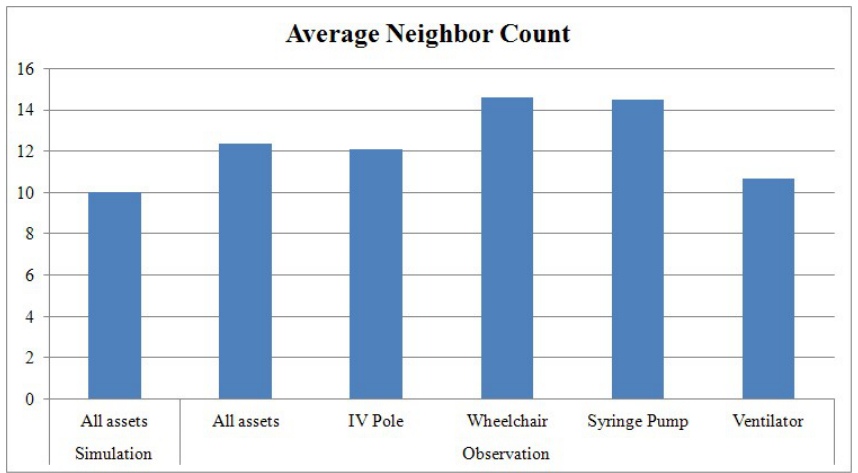
Figure 7. Average neighbor count in the simulation and in the emergency